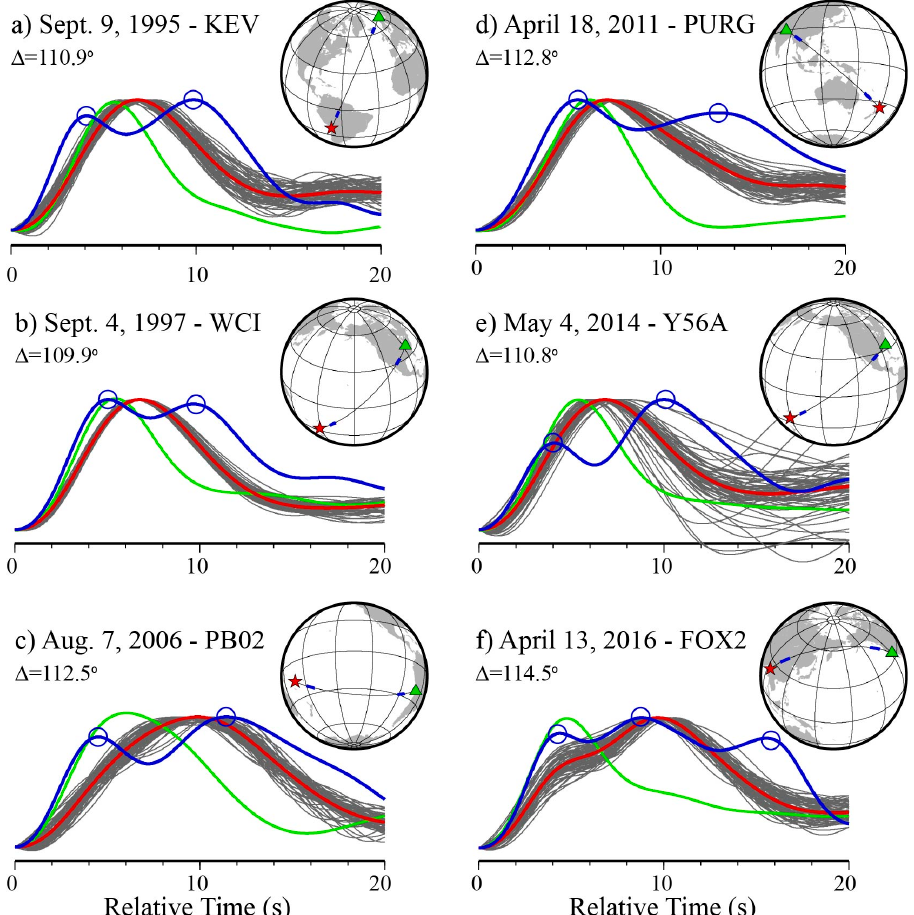
Figure 6. Each panel shows an example waveform that was classified as anomalous. In each panel, the blue trace is the seismic observation and the individual peaks are indicated with open circles. The green trace shows the source-time function estimate for the event. The red trace shows the synthetic prediction for the PREM model convolved with the source-time function. Gray traces are 100 realizations of noise added to the synthetic, where the noise was randomly taken from the data trace. In each panel, the source (red star) and receiver (green triangle) and Pd-segments on the CMB (heavy blue lines) are shown in the map inset. Recordings are shown at stations ( a ) KEV—Kevo, Finland, ( b ) WCI—Wyandotte Cave Indiana, USA, ( c ) PB02—Salar Grande, Chile, ( d ) PURG—Purang, Tibet, ( e ) Transportable Array station Y56A, and ( f ) FOX2—Fox Airport, California,